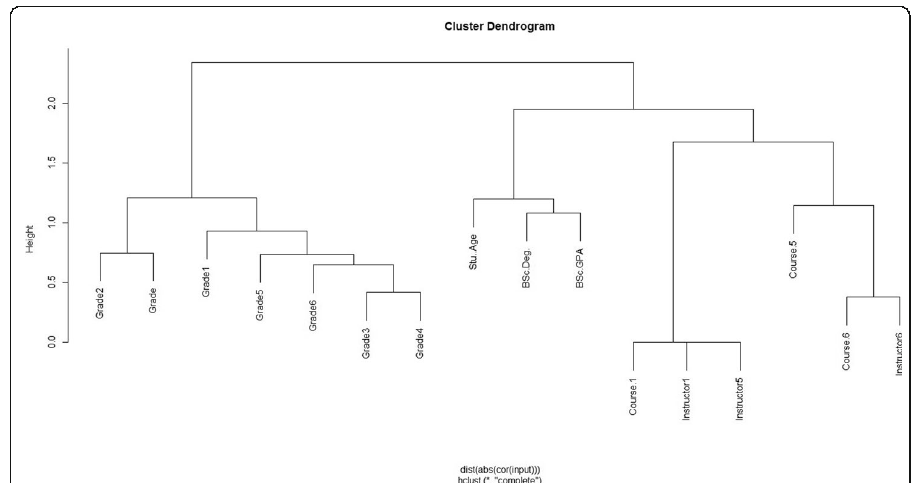
Fig. 4 Python code for the new arrangement for the dataset, required for research question 1 needed